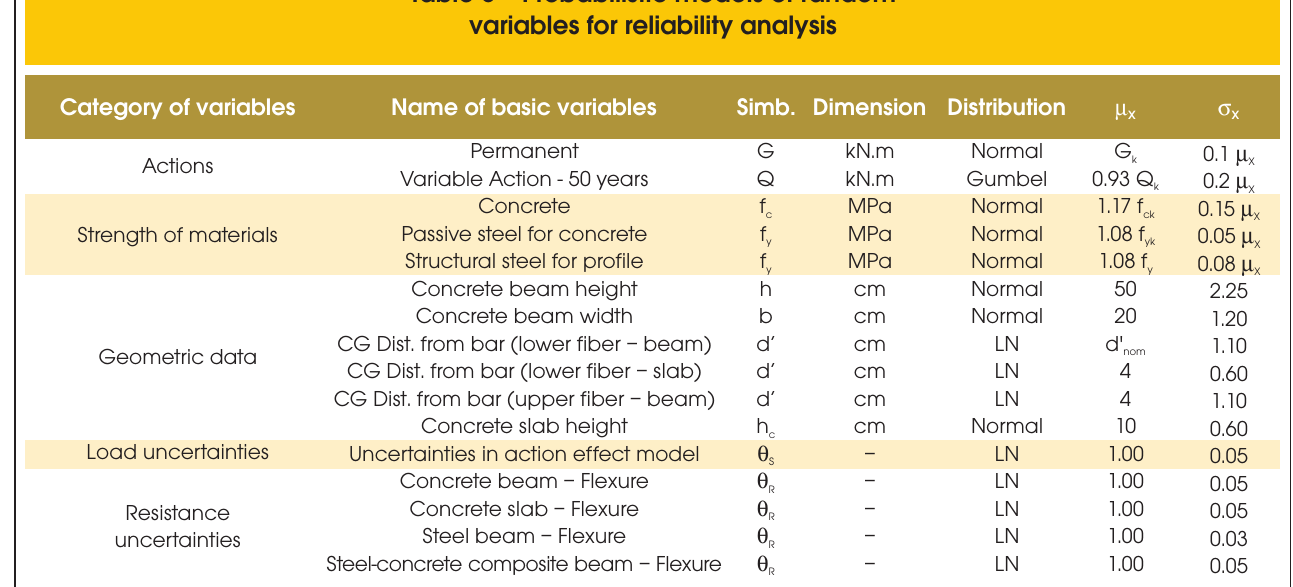
Table 6 – Probabilistic models of random